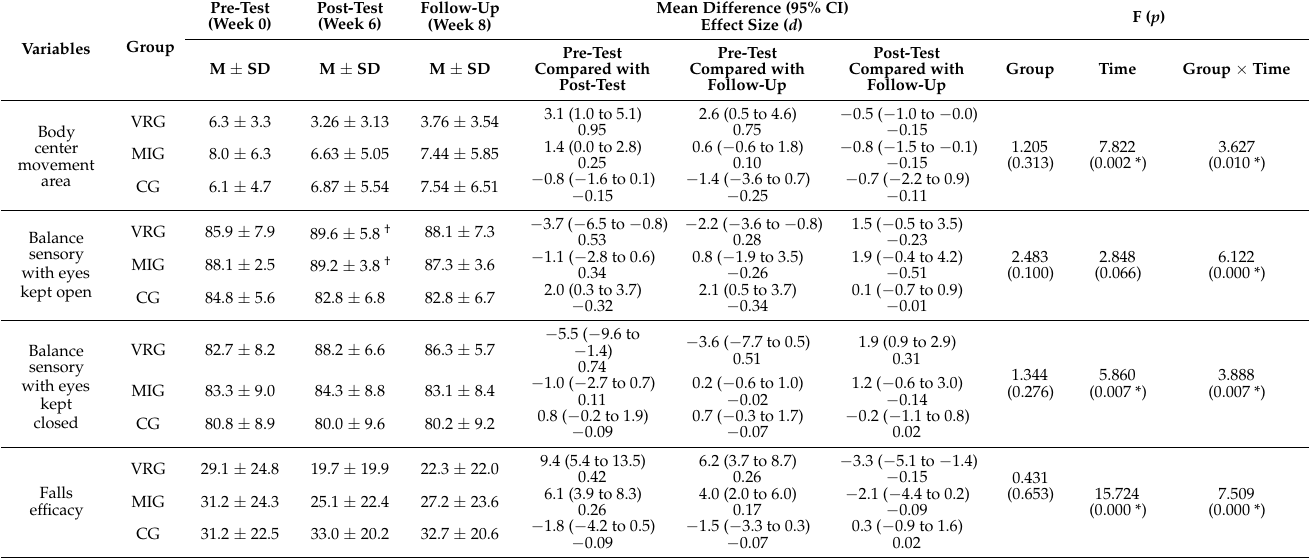
Table 2. A comparison of balance and falls efficacy scores during the intervention in each group (body center movement area unit: cm 2 , balance sensory related to people eyes and falls efficacy unit: